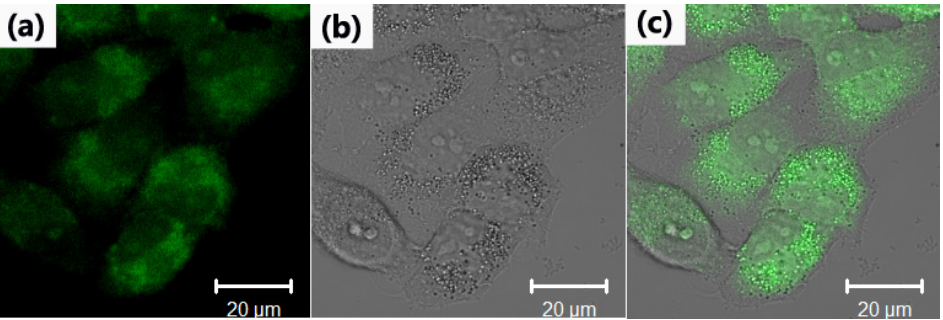
Figure 7. ( a ) A confocal fluorescence microphotograph of Hela cells labeled with the CDs ( λ ex: 405 nm); ( b ) A bright field microphotograph of the cells; ( c ) An overlay image of ( a ) and ( b ).